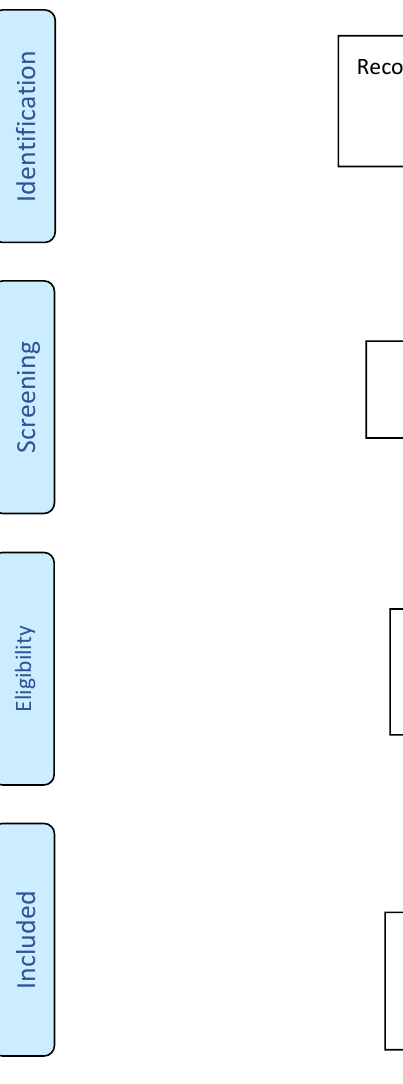
Figure 1. Preferred Reporting Items for Systematic Reviews and Meta-analysis.